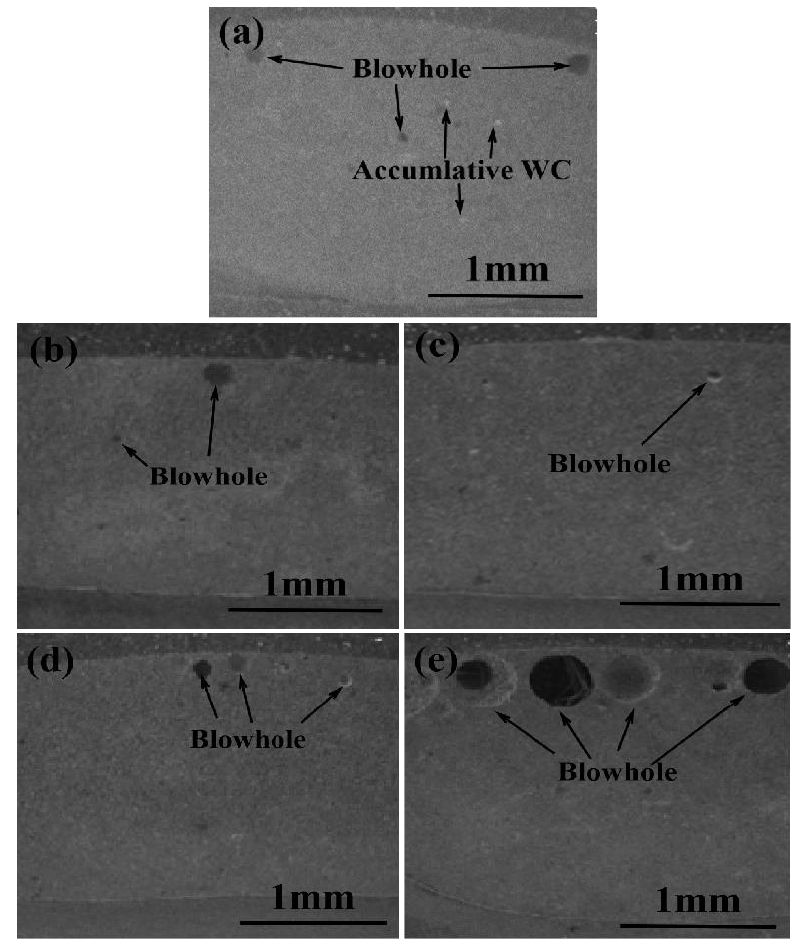
Figure 3. Morphology of the cladding layer with differing CeO 2 contents: ( a ) 0.0%, ( b ) 0.5%, ( c ) 1.0%, ( d ) 1.5%, and ( e ) 2.0%.